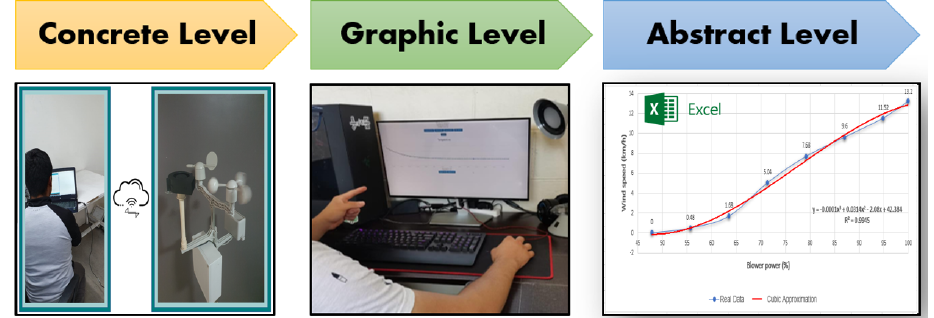
Figure 19. Complete instructional